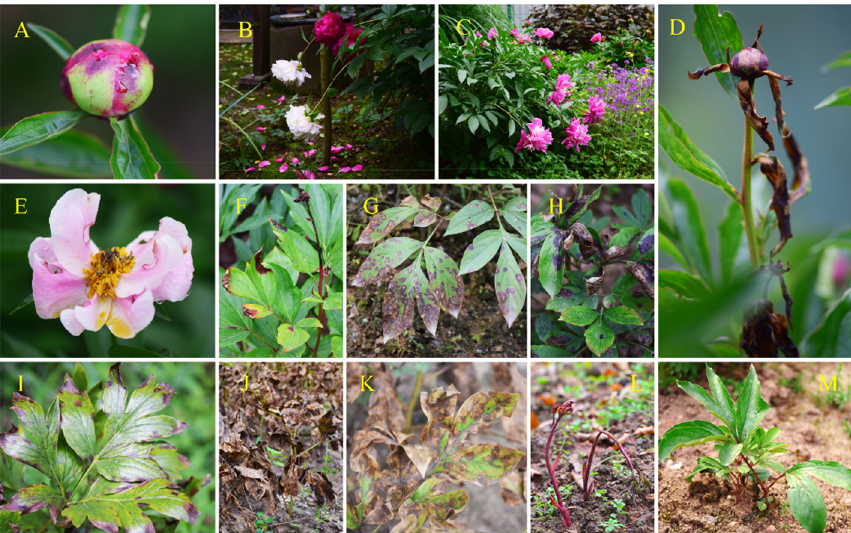
Figure 1. Challenges encountered in the cultivation and application of the herbaceous peony at low latitudes. ( A – H ) High spring temperatures and high humidity caused stem bending, flower bud abortion and severe diseases; ( I – K ) High summer temperatures induced heat damage and premature withering of aboveground parts; ( L , M ) High autumn and winter temperatures caused insufficient chilling requirement and induced subsequent abnormal flowering and vegetative growth.